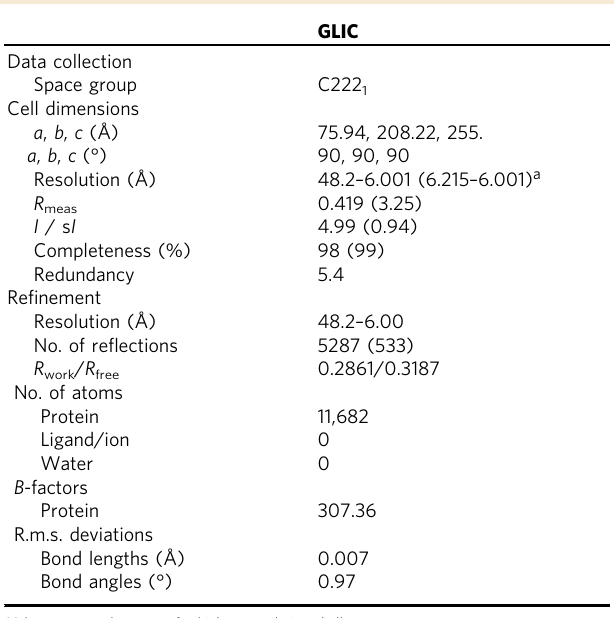
crystallization method. The crystals were found to be organized in a different space group compared to crystals of the same protein grown by vapor diffusion, with the noteworthy additional features of tighter packing of the protein and the stabilization of its closed